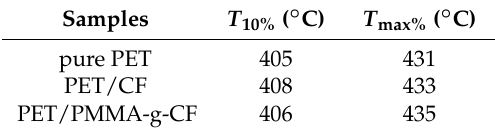
Table 5. TG and DTG data of pure PET, PET/CF, and PET/PMMA-g-CF composites.